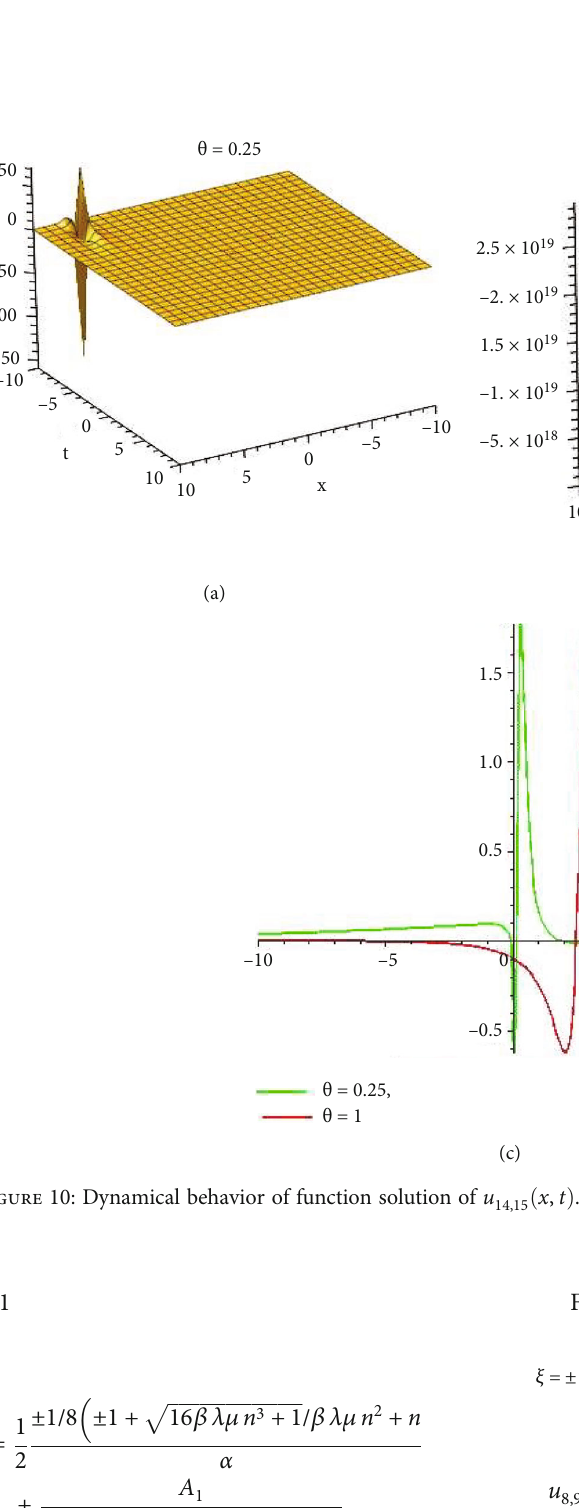
ffiffiffiffiffiffiffiffiffiffiffiffiffiffiffiffiffiffiffiffiffiffiffiffiffiffi p 16 β λμ n 3 + 1